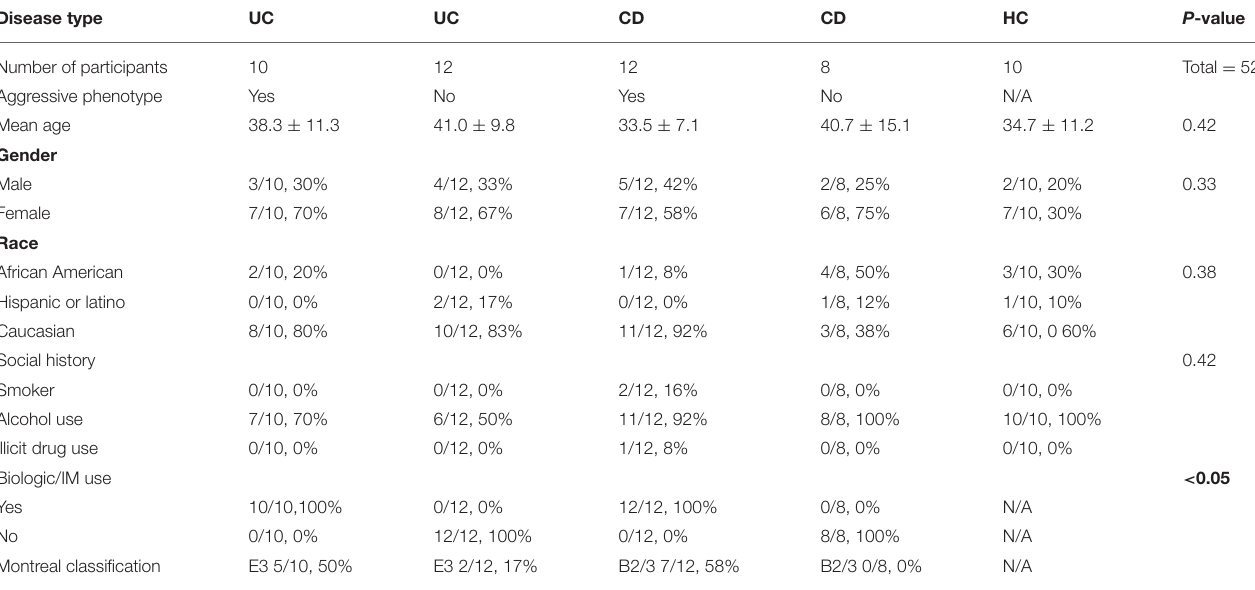
TABLE 1 | Demographics of IBD subjects at